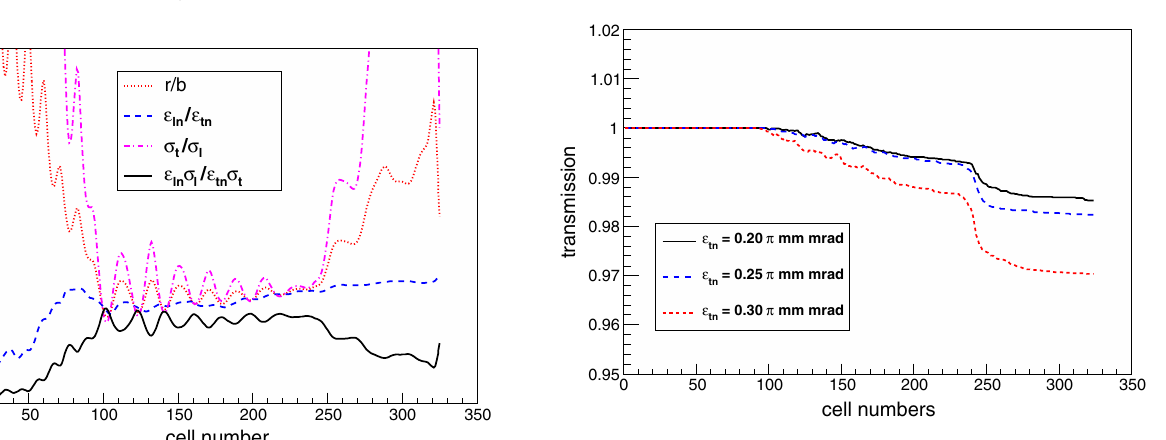
FIG. 2. Emittance evolution as functions of cell number. The solid line represents the transverse normalized rms emittance, and the dashed line is the longitudinal one.